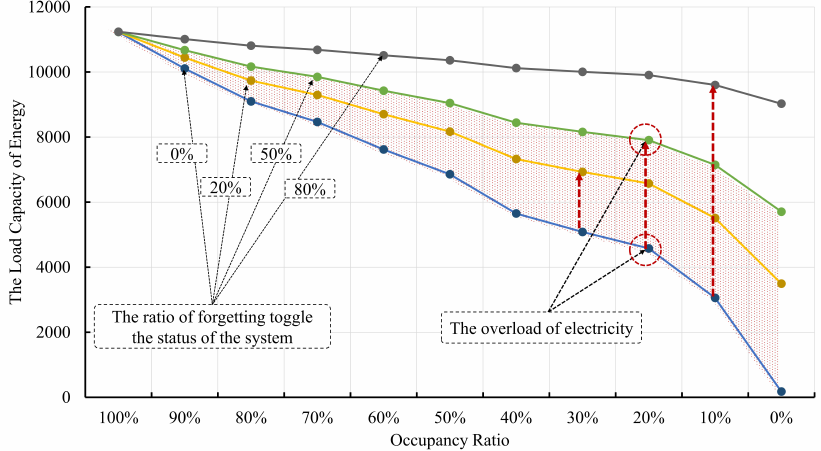
Figure 5. The load capacity of energy for the occupancy status compared with forgetting to toggle the status of the intelligent lighting system.